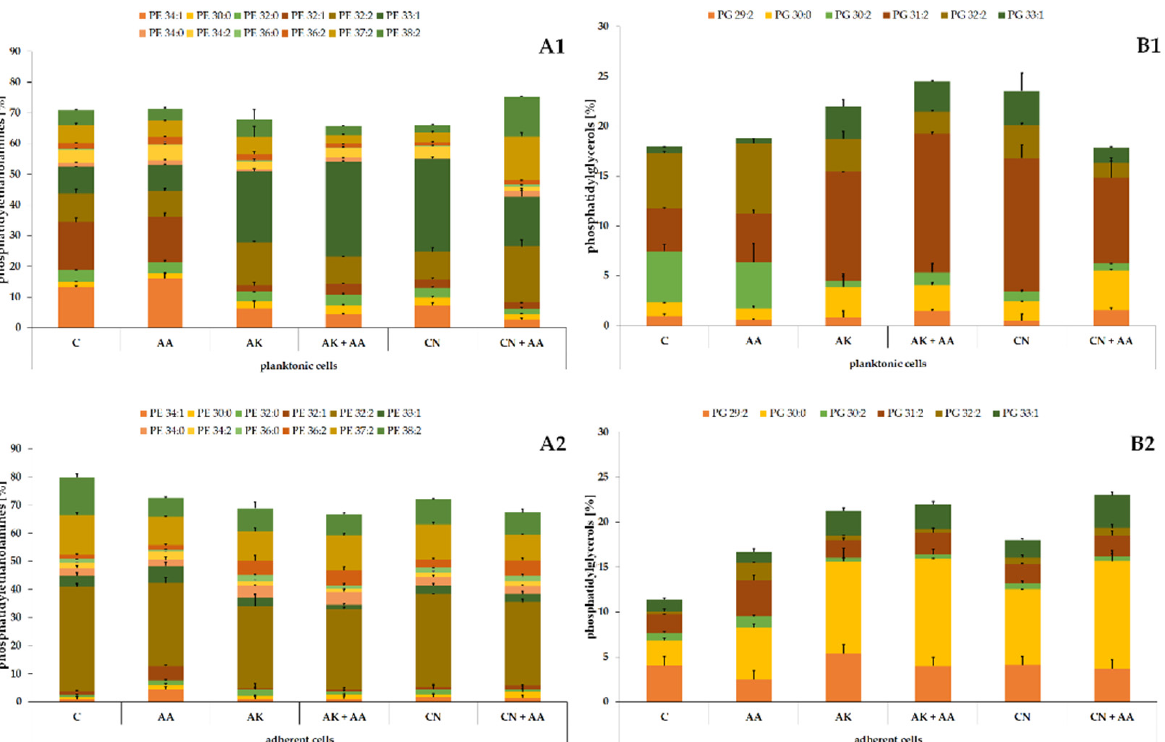
Figure 2. Percentage content of phosphatidylethanolamines ( A ) and phosphatidylglycerols ( B ) iden- tified in the planktonic ( 1 ) and adherent ( 2 ) cells of the P. mirabilis ATCC 29906 strain treated with ascorbic acid, amikacin, or gentamicin. Legend: C—control, AA—ascorbic acid, AK—amikacin, CN—gentamicin.